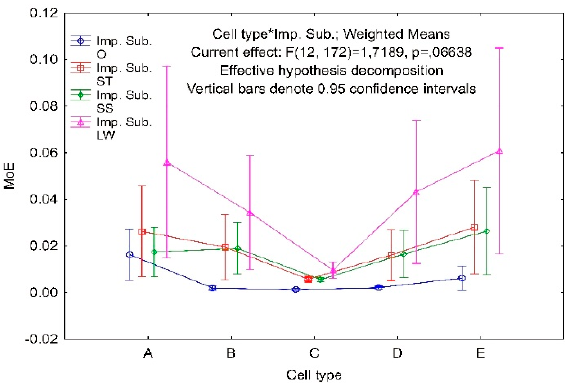
Figure 18. The combined e ff ect of the type of cell and the method of impregnation on the modulus of elasticity.